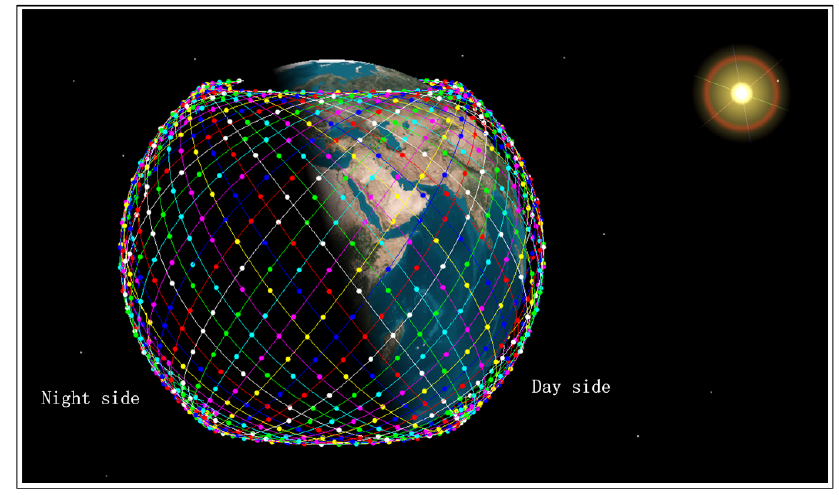
Figure 3. Constellation lighting diagram.